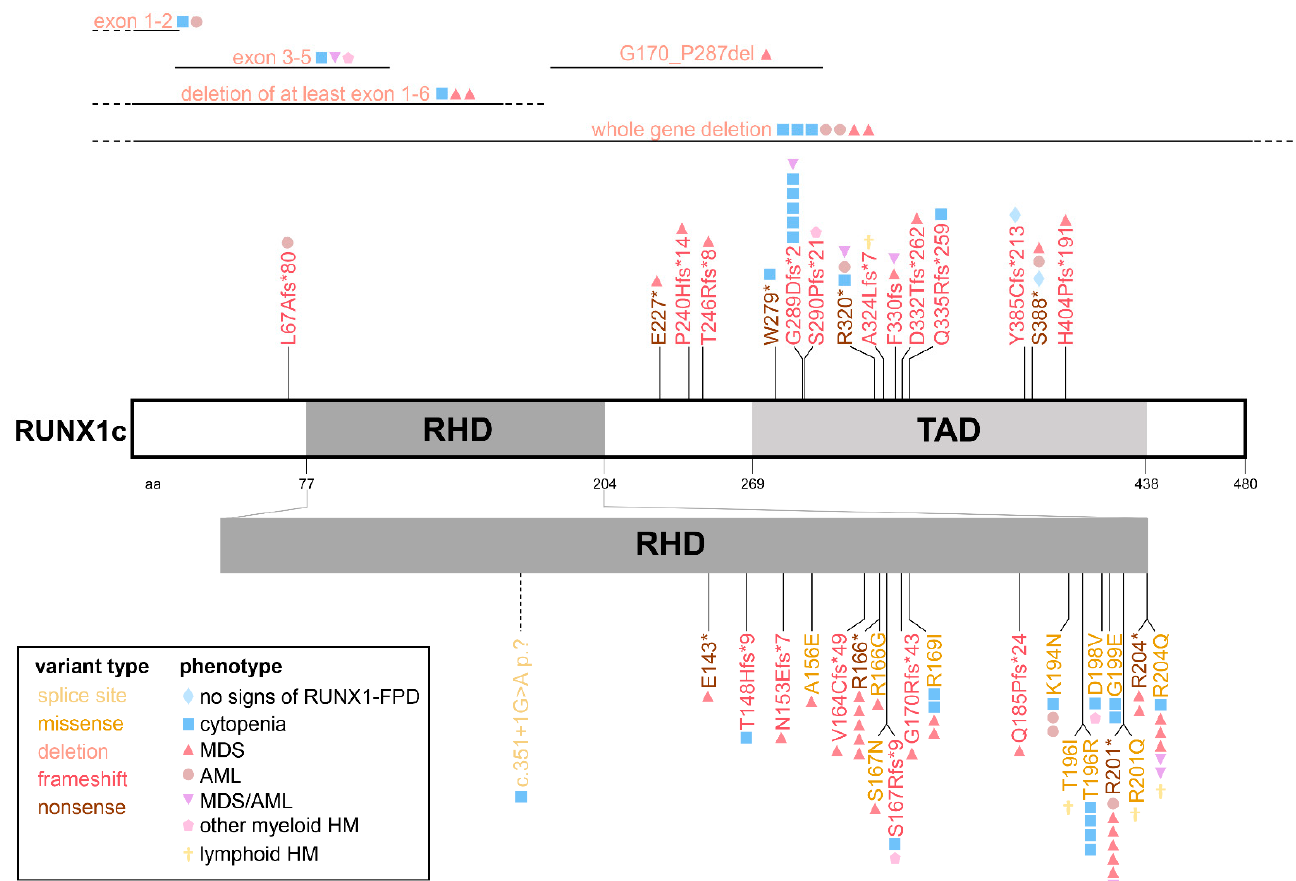
Figure 2. RUNX1 germline variants in the retrospective RUNX1-FPD cohort. Schematic visual- ization of germline RUNX1 variants included in the retrospective RUNX1-FPD cohort including variant type and patients’ phenotype. Nomenclature refers to transcript variant 1